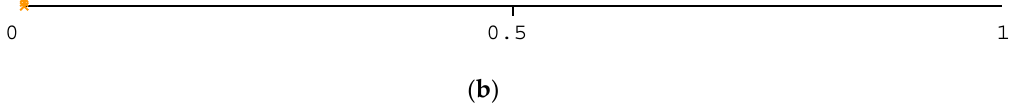
Figure 8. ROC curves of the optimal set obtained using chi-squared attribute evaluation: ( a ) naïve Bayes classifier and ( b ) logistic regression classifier.